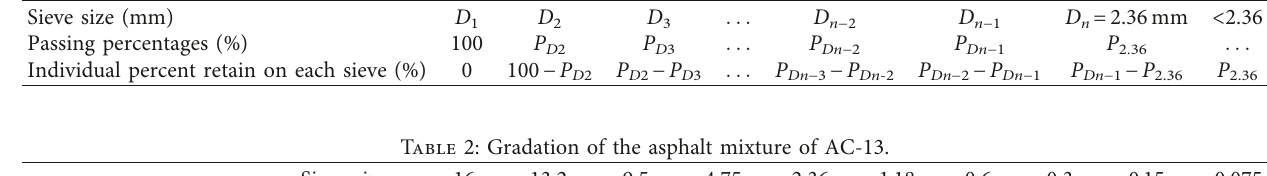
Table 1: Percentages of aggregate gradation.